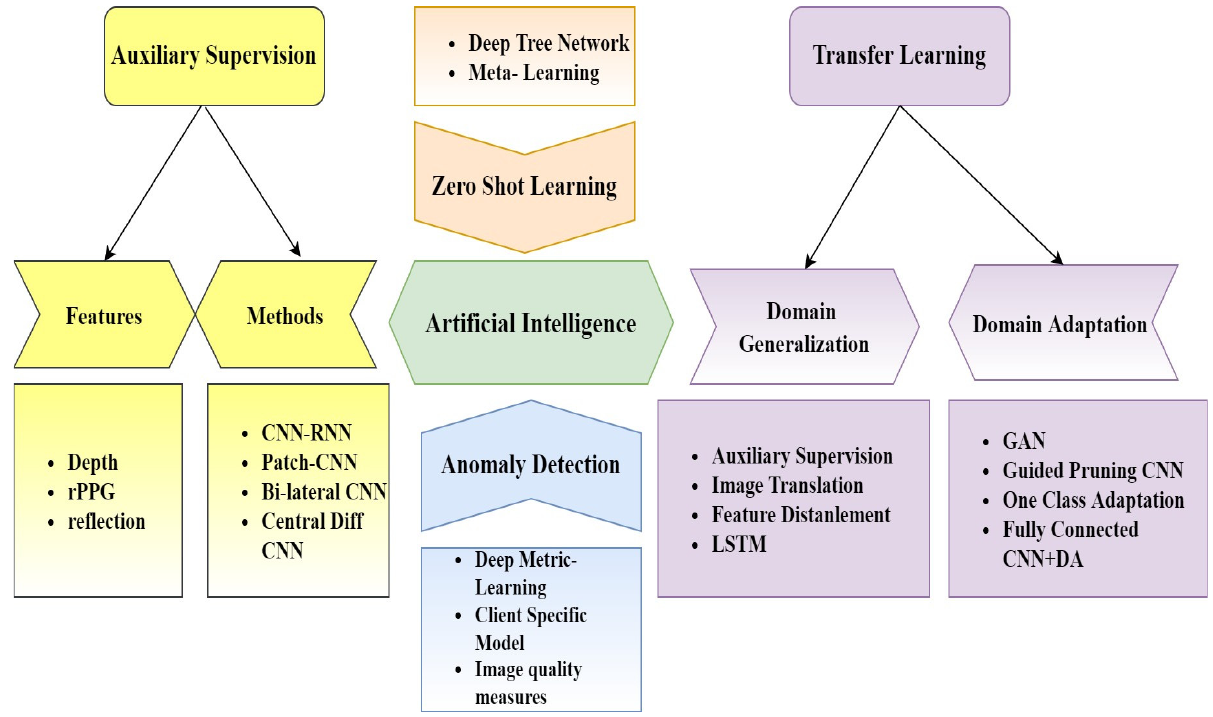
Figure 9. Deep learning approaches for Face liveness detection.